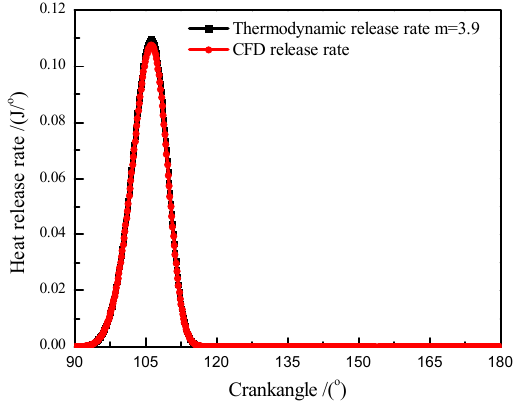
Figure 6. Verification of the thermodynamic